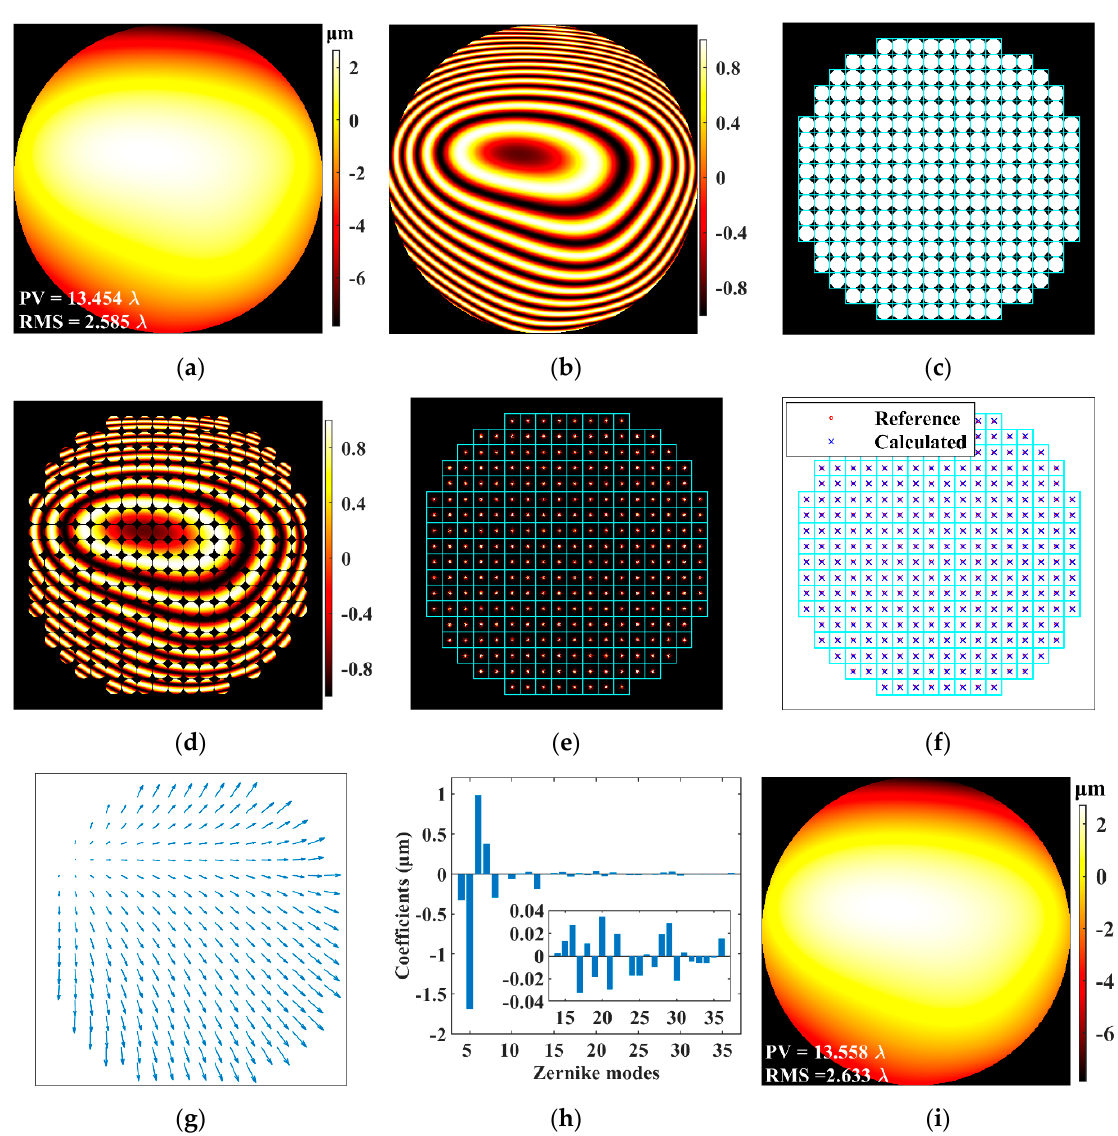
Figure 1. Main data processing steps and corresponding results of vSHWS. ( a ) Wavefront W P to be measured; ( b ) real part of complex electric field E generated from ( a ); ( c ) virtual LA; ( d ) real part of amplitude-filtered E ; ( e ) diffracted spots of the entire aperture; ( f ) calculated and reference centroid positions; ( g ) displacement vectors of centroids; ( h ) calculated Zernike coefficients; ( i ) reconstructed wavefront W R .